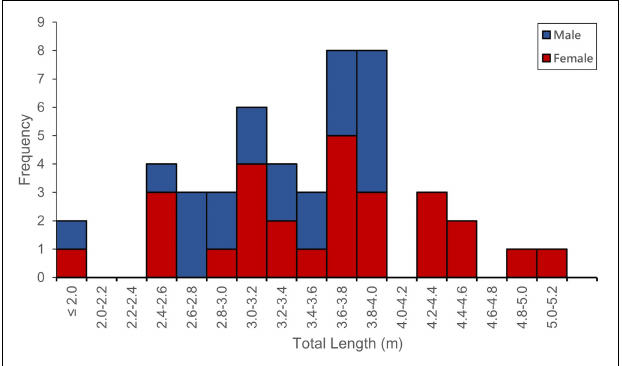
FIGURE 1 | Frequency-size distribution for 48 white sharks caught and tagged in the western North Atlantic between 2012 and 2020.